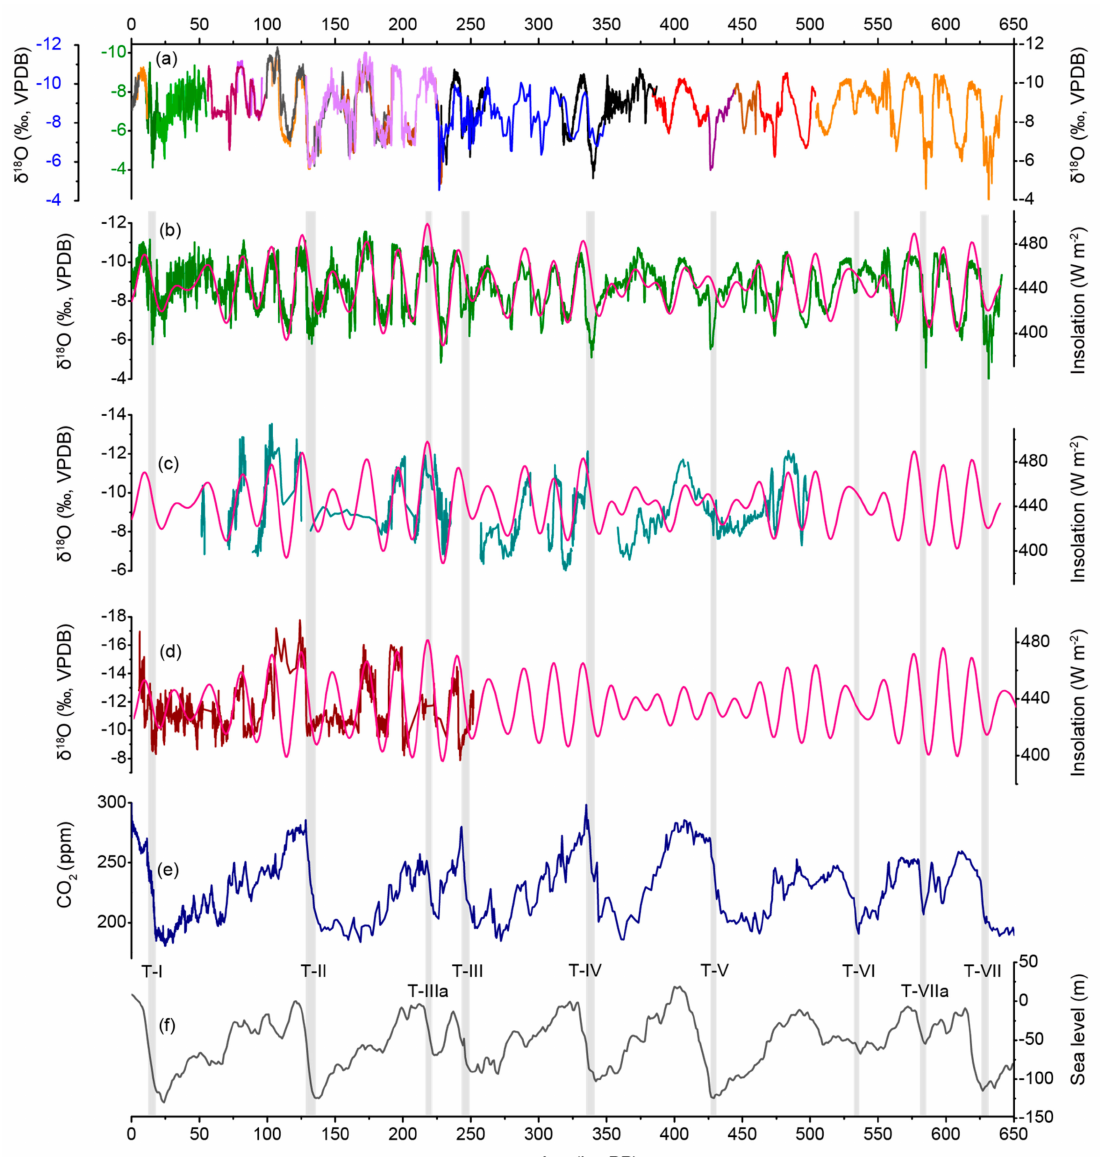
Figure 5. Orbital scale changes in speleothem δ 18 O records from China and comparison with other records. ( A ) Multi-speleothem record from China: three records from the Hulu Cave (green curves; green left y -axis), two records from the Linzhu Cave (blue curves; blue left y -axis), and 16 records from the Sanbao Cave (all other colors; black right y -axis). ( B ) The 640 kyr EASM composite record from ( A ) [1]. ( C ) The composite δ 18 O record from the Kesang Cave (cyan curve) [21]. ( D ) The composite δ 18 O record from the Xiaobailong Cave (brown curve) [13]. Pink curves in panels B – D show 21 July insolation at 65 ◦ N [206]. ( E ) The composite CO 2 record [207]. ( F ) The composite sea level record [208]. Vertical gray bars mark the timing of seven glacial terminations, which correspond with weak monsoon